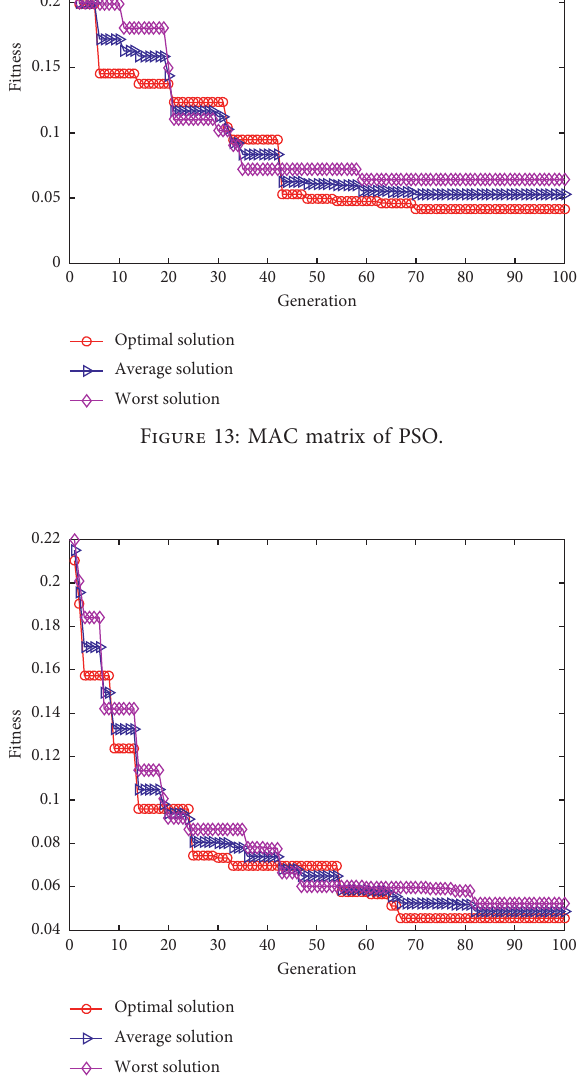
Figure 12: MAC matrix of GA.